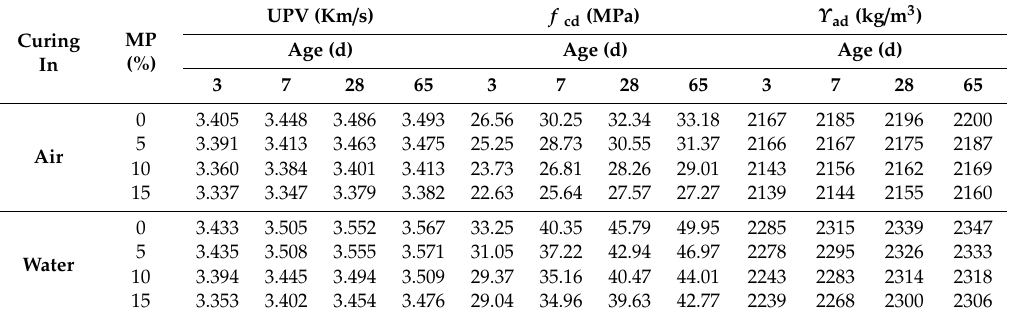
Table 3. Mean value of compressive strength, UPV, and apparent density of mortar containing MP. Curing In